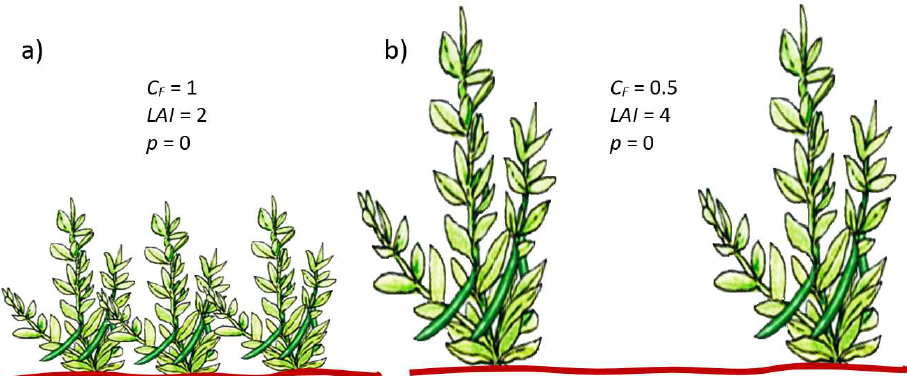
Figure 7. For faba bean, two different attributions of the parameters LAI , throughfall index, p , and fraction of ground covered by the canopy, C F .